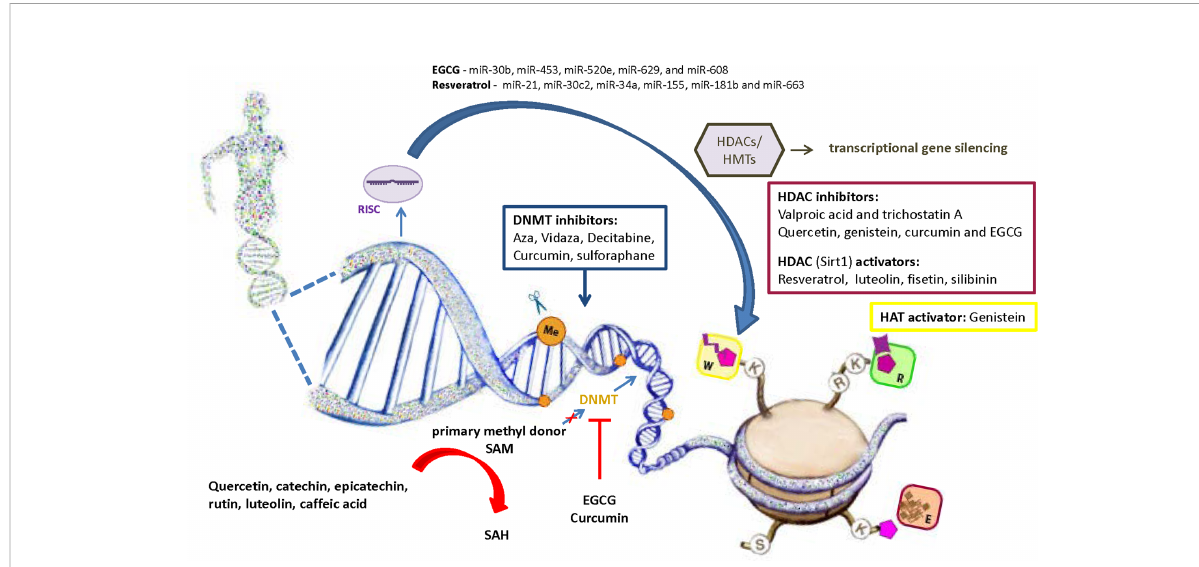
FIGURE 4 Role of natural antioxidants in the regulation of epigenetic mechanisms involved in diabetes pathogenesis. Antioxidants are becoming powerful alternative approach in epigenetic therapy. Besides synthetic compounds as a potential epigenetic modi fi ers (Aza, Vidaza, Decitabine (DAC), valproic acid and trichostatin A), it has been shown that polyphenolic compounds have the ability to modulate epigenetic related mechanisms including DNA methylation, histone modi fi cation and regulation of miRNA expression. SAM, S-Adenosyl methionine; SAH, S-adenosylhomocysteine; DNMTs, DNA methyltransferases; HATs, Histone acetyltransferases; HDACs, Histone deacetylases; HMTs, Histone methyltransferases; RISC, RNA-induced silencing complex; EGCG, epigallocatechin gallate; W, writers of histone marks; R, readers of histone marks; E, erasers of histone